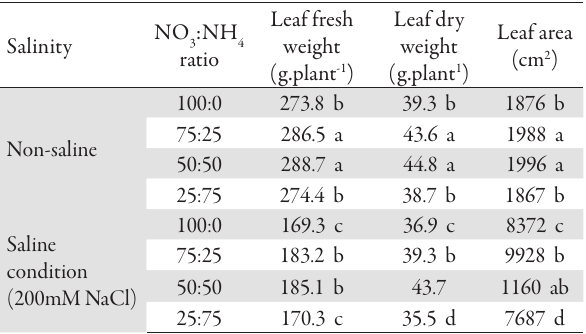
Tab. 2. The effects of salinity and NO vegetative characteristics of canola plants